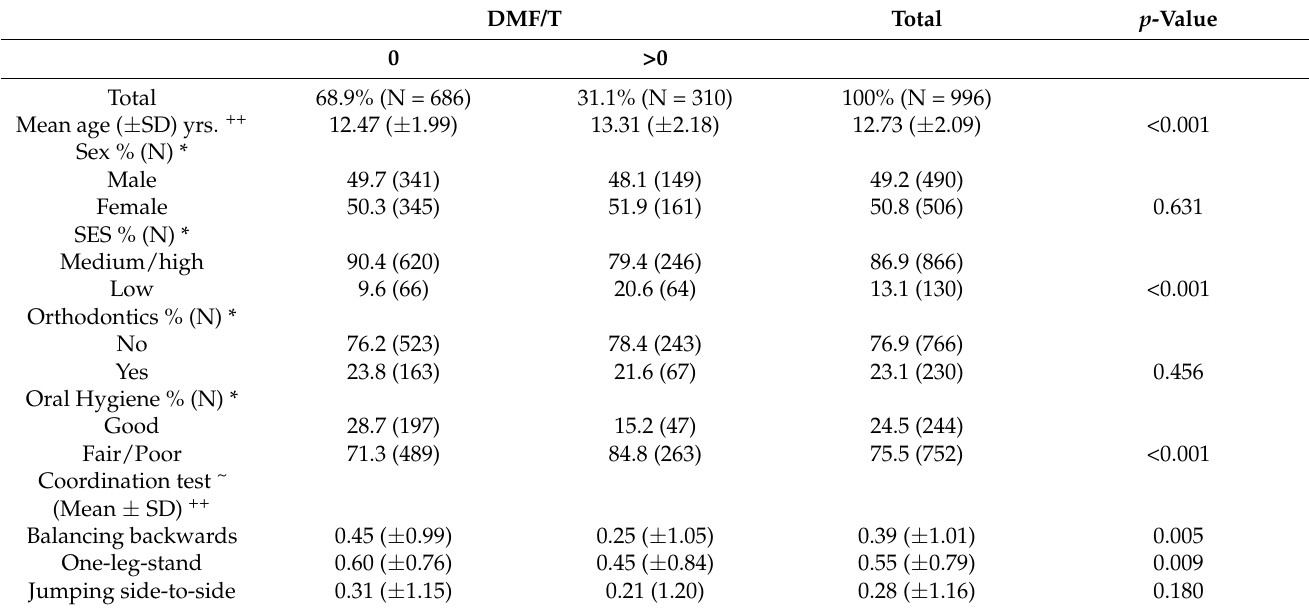
Table 2. Association of dental caries experience (DMF/T) and SES, sex, age, orthodontic treatment, oral hygiene (plaque level) and coordination skills in children and adolescents of 10 to 18 years (Leipzig, Germany).